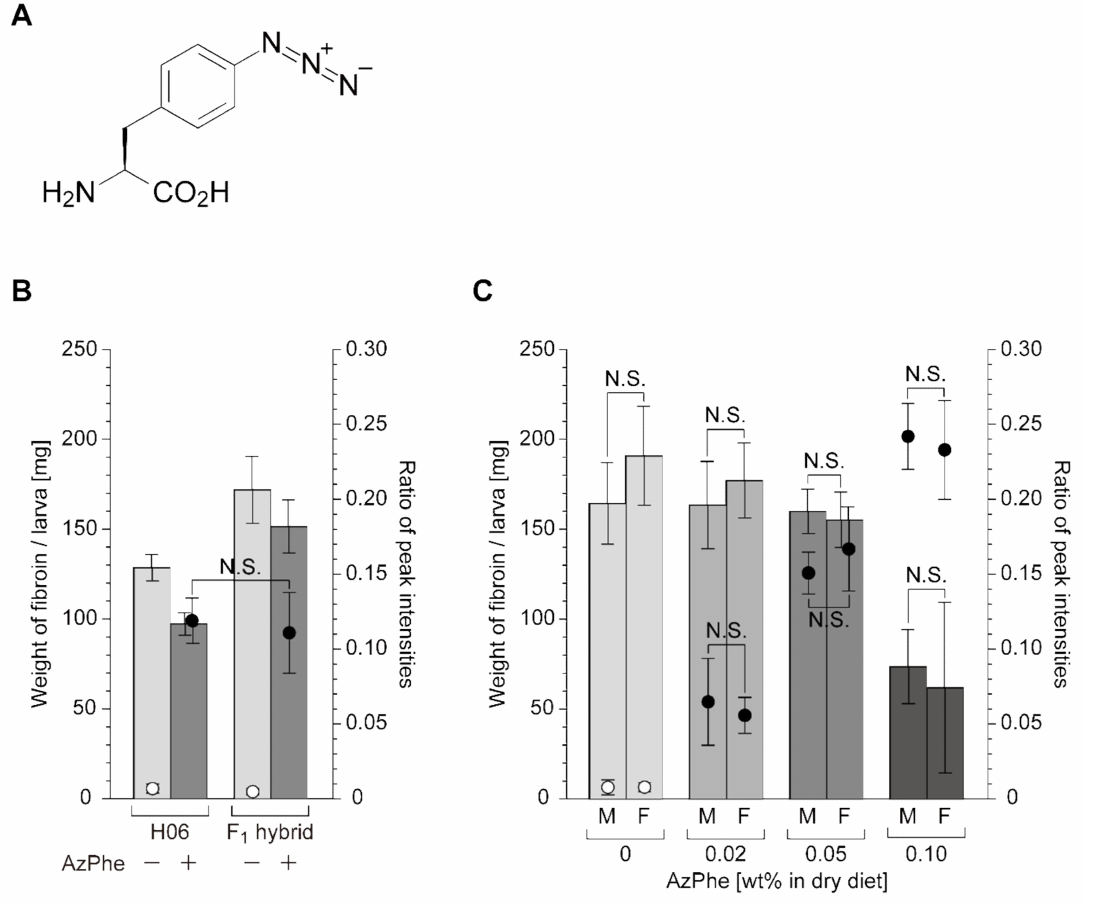
Figure 1. Fibroin production and the AzPhe incorporation rate. All values in this figure are the average of four independent experiments, where each experiment employed three male larvae. Bar plots represent the amounts of fibroin. Open and closed circles represent the ratio of peak intensities (870 Da/855 Da) in MALDI-TOF-MS analysis (Figure S3) of a FibL-derived peptide as an index of AzPhe incorporation [10]. The plots from the control experiments without AzPhe administration (open circles) show the levels of background signals. The error bars represent standard deviations ( n = 4). N.S. stands for not statistically significant by t -test. ( A ) Chemical structure of 4-azido-L-phenylalanine, AzPhe. ( B ) Comparison between the H06 strain and its F 1 hybrid with a high silk-producing strain, Nichi509 × Nichi510. Fifth instar larvae were fed a diet containing AzPhe (0 or 0.05 wt% in dry diet) from their third day until the start of spinning. Representative MALDI-TOF-MS spectra are shown in Figure S3. ( C ) Dependence on the amount of AzPhe in the diet. Fifth instar larvae were fed a diet containing different amounts of AzPhe (0, 0.02, 0.05, or 0.1 wt% in dry diet) from their third day until the start of spinning. Male (M) and female (F) larvae of the F 1 hybrid were separately